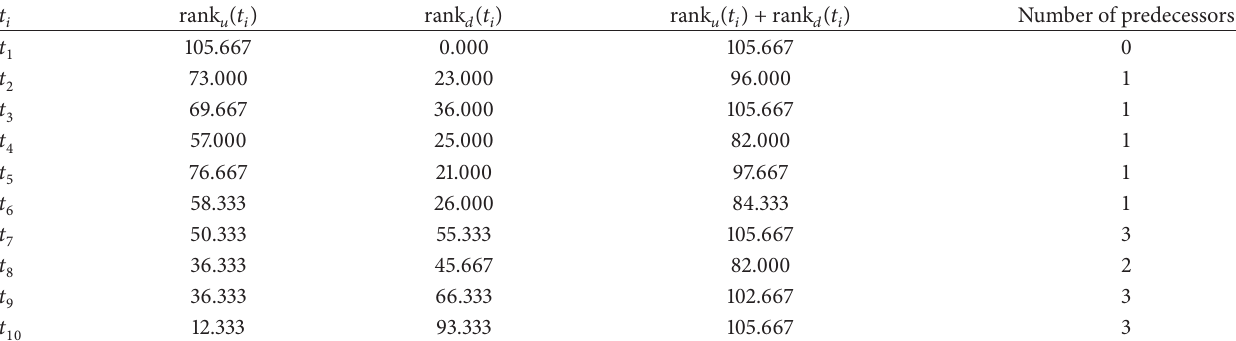
Table 2: Values of attributed used in HCPPEFT algorithm for task graph in Figure 2.